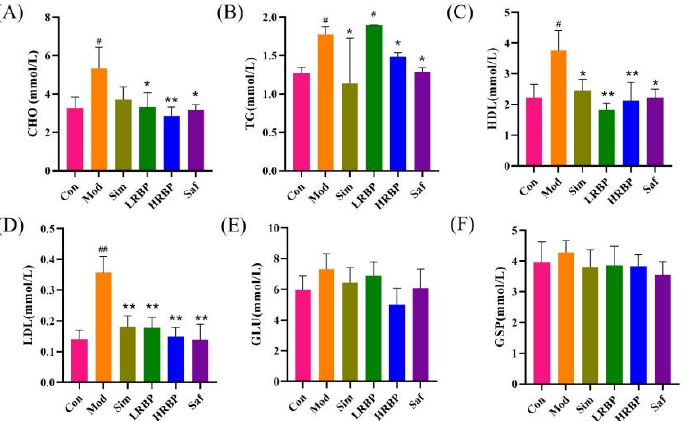
Figure 1. Effect of RBPs on blood lipid and blood sugar in Mice. ( A – D ) Serum levels of CHO, TG, HDL, and LDL. ( E , F ) Serum levels of GLU and GSP. # p < 0.05, ## p < 0.01 compared to Con group, * p < 0.05, ** p < 0.01 compared to Mod group. Con, control group fed with normal diet; Mod, model group fed with HFD; Sim, positive control group fed with HFD and treated with simvastatin; LRBP, low dose RBPs group fed with HFD and treated with 200 mg/kg RBPs; HRBP, high dose RBPs group fed with HFD and treated with 600 mg/kg RBPs; Saf, safety evaluation group fed with normal diet and treated with 600 mg/kg RBPs.